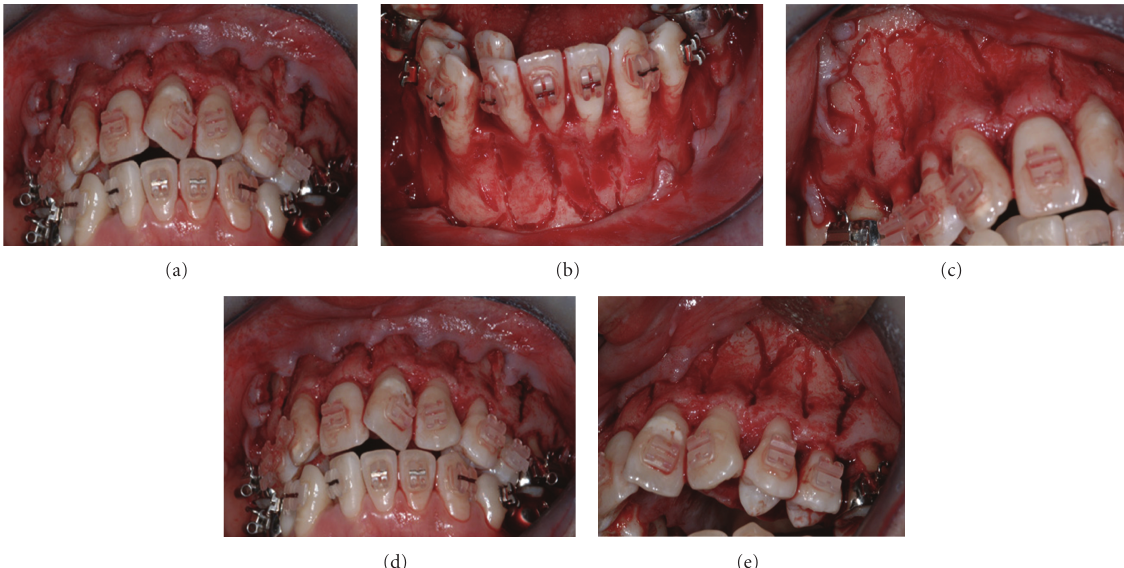
Figure 5: Maxillary and mandibular corticotomy of the buccal side.